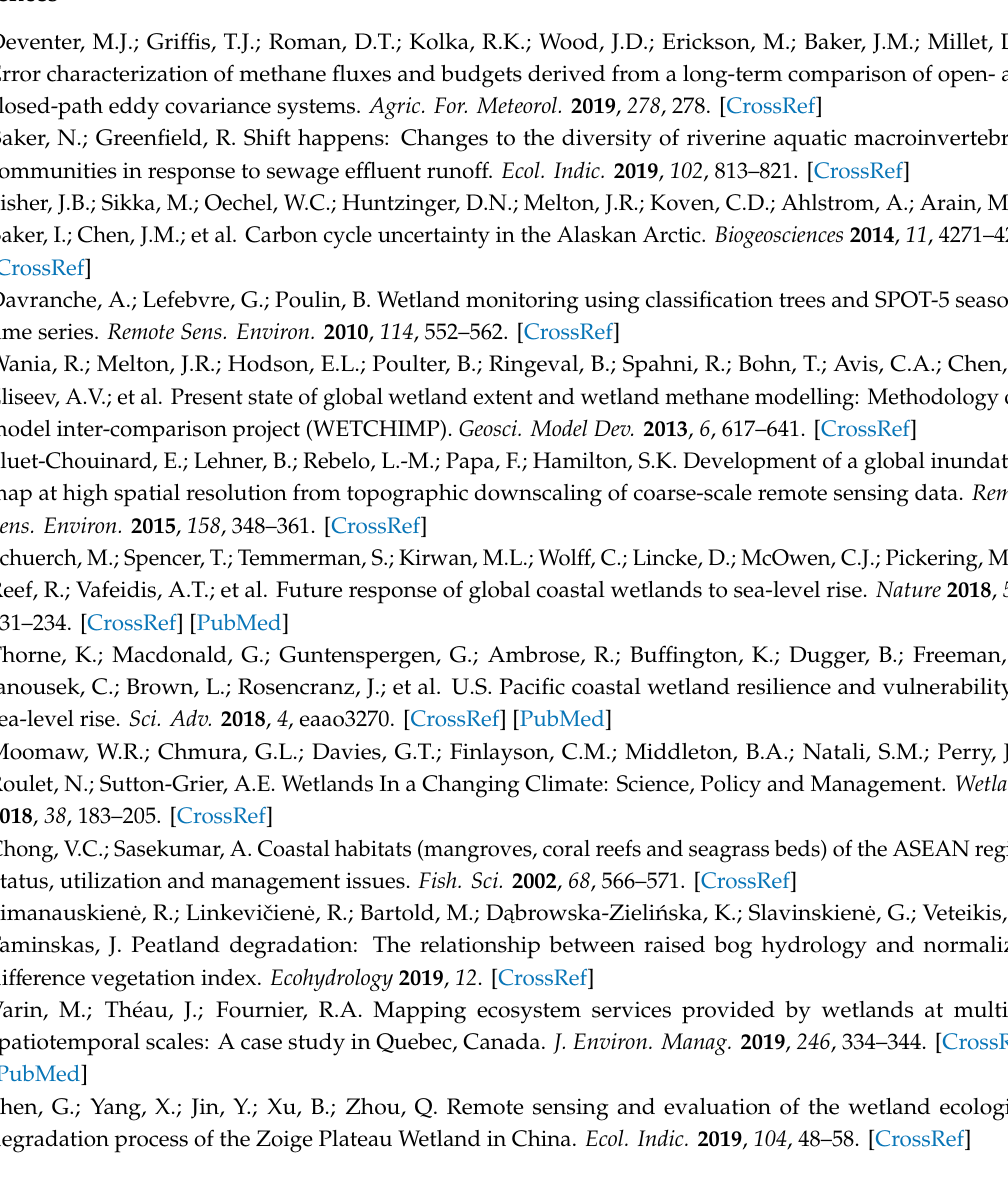
Table S1: Percentages ( > 0.01%) of one-step changes by codes, 1965–2015 (%), Table S2: Percentages ( > 0.01%) of two-steps changes by codes, 1965–2015